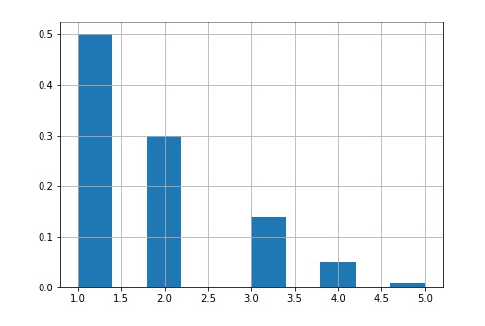
Figure 5. Distribution of final fraud score.